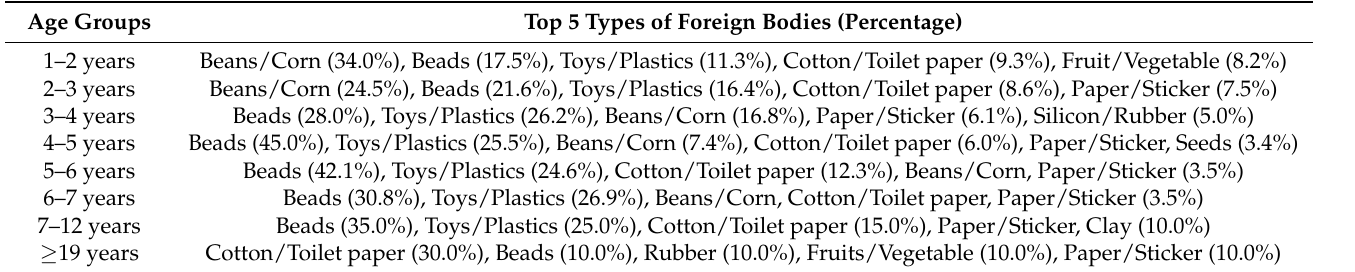
Figure 3. The types of nasal foreign body according to the sex. Table 2. Top 5 types of nasal foreign bodies according to the age groups.